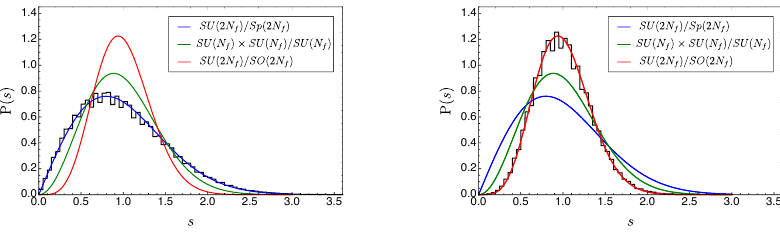
Figure 4. The unfolded density of the spacings between subsequent Dirac eigenvalues for the fun- damental (left) and antisymmetric (right) representations. The black histogram denotes the numerical data, while the coloured solid lines are the χ RMT predictions. Figures from Ref.